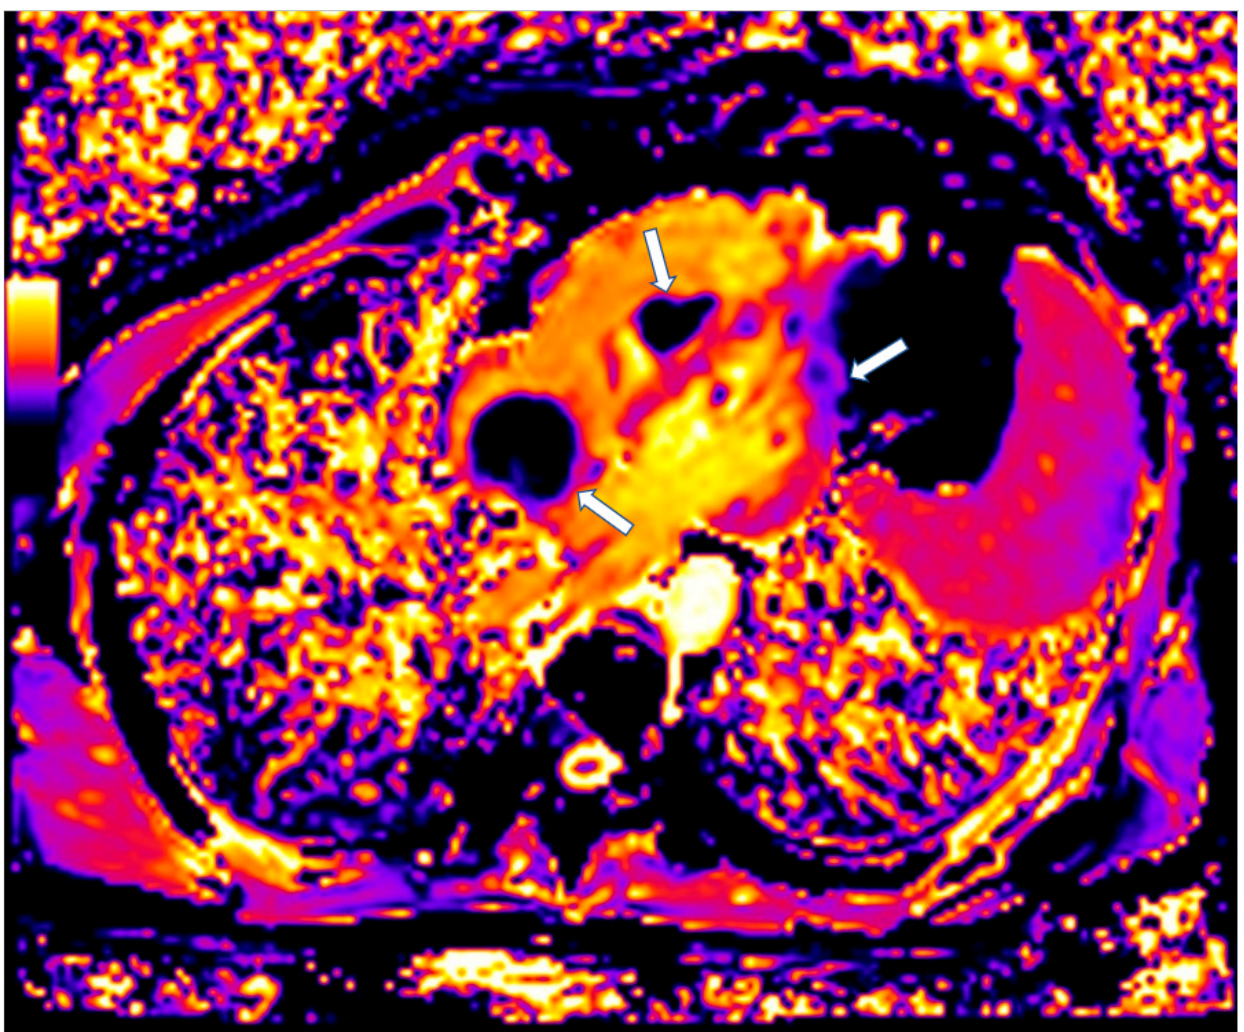
Figure 7. Four chamber T1 mapping showing LV infiltration and RV-Right atrium masses (arrows) due to melanoma.